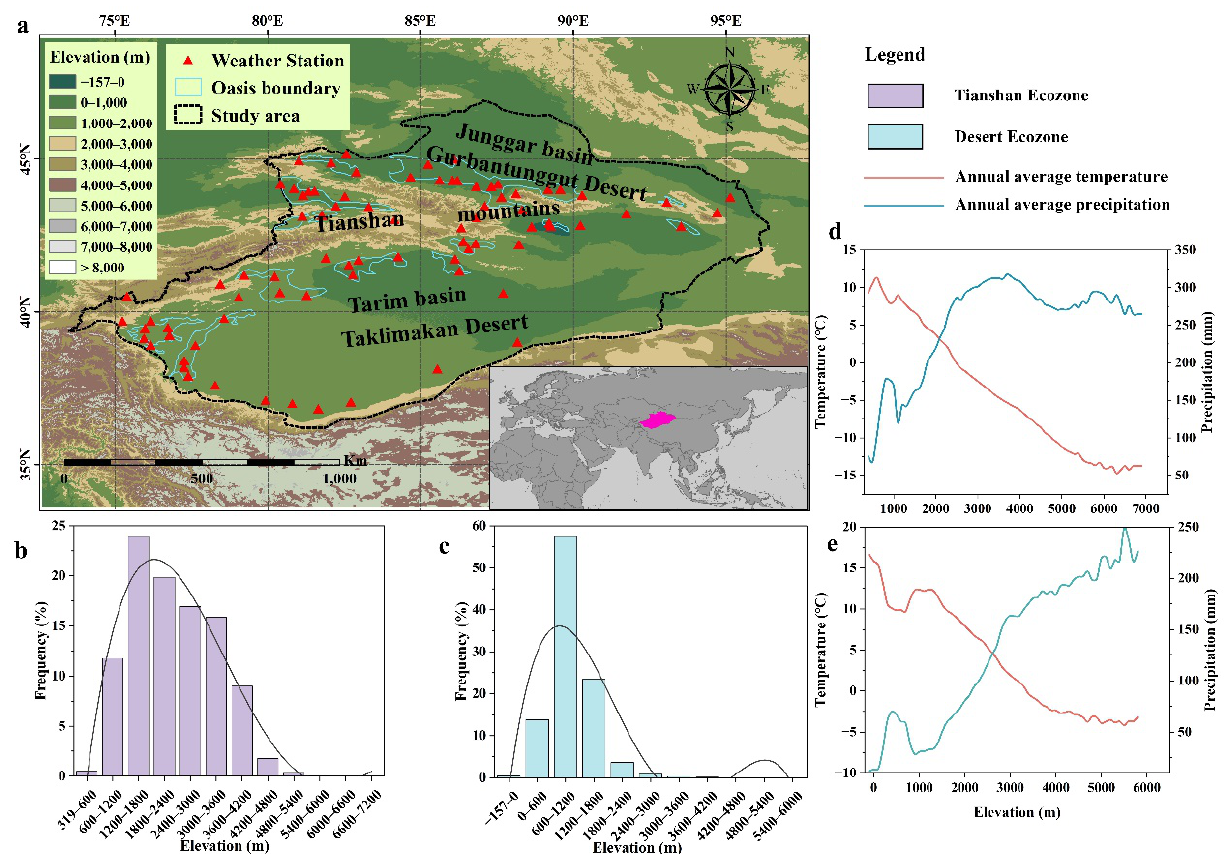
Figure 1. Geographical and climatic features of the TMDE. ( a ): geographical location of the study area. ( b , c ): frequency (percentage) distribution of land area across different altitudes in Tianshan Mountains Ecozone and Desert Ecozone, respectively. ( d , e ): distribution of temperature and precipitation across altitudes in Tianshan Mountains Ecozone and Desert Ecozone, respectively.